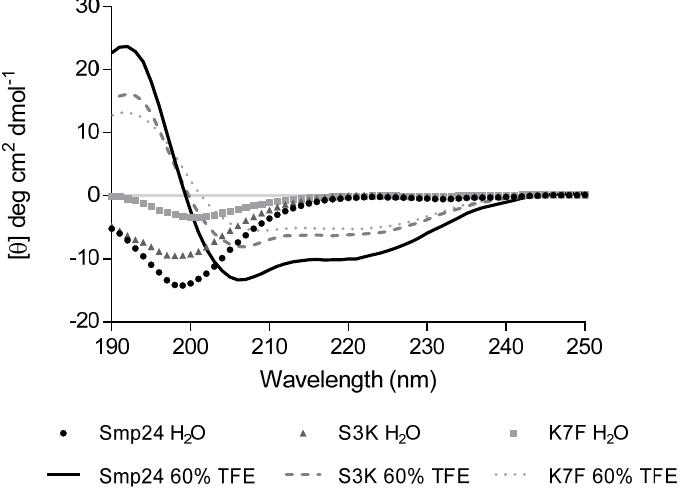
Figure 2. Solvent-dependent effects of Smp24, Smp24 S3K and Smp24 K7F on peptide secondary structure determined by CD. Observable differences were seen between Smp24 and most of the modified peptides.